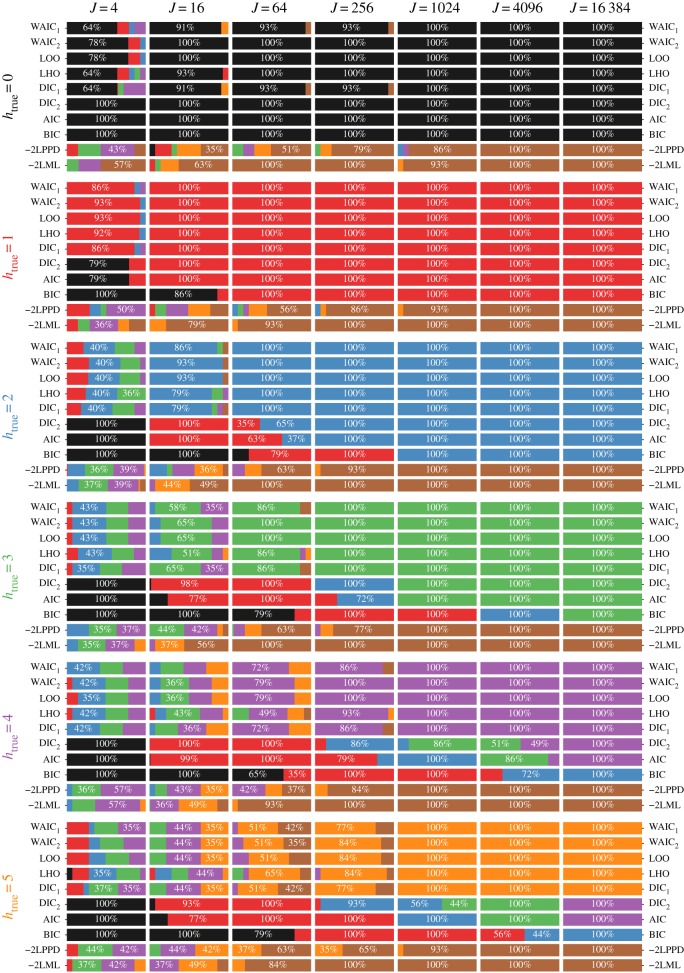
Chosen degree of memory h in simulations for varying true degrees of memory htrue and number of observed trajectories J. Choices made on the basis of model with the lowest value of the given criterion. Rows correspond to model selection under a given degree of memory. Columns correspond to the number of trajectories. Depicted are the per cent of simulations in which each degree of memory is selected using the different model evaluation criteria (per cents of at least 20 are labelled). Colours coded based on the degree of memory: (0: black, 1: red, 2: blue, 3: green, 4: purple, 5: orange). Example: For htrue = 1 and J = 4, the WAIC1 criteria selected h = 1 approximately 86% of the time.